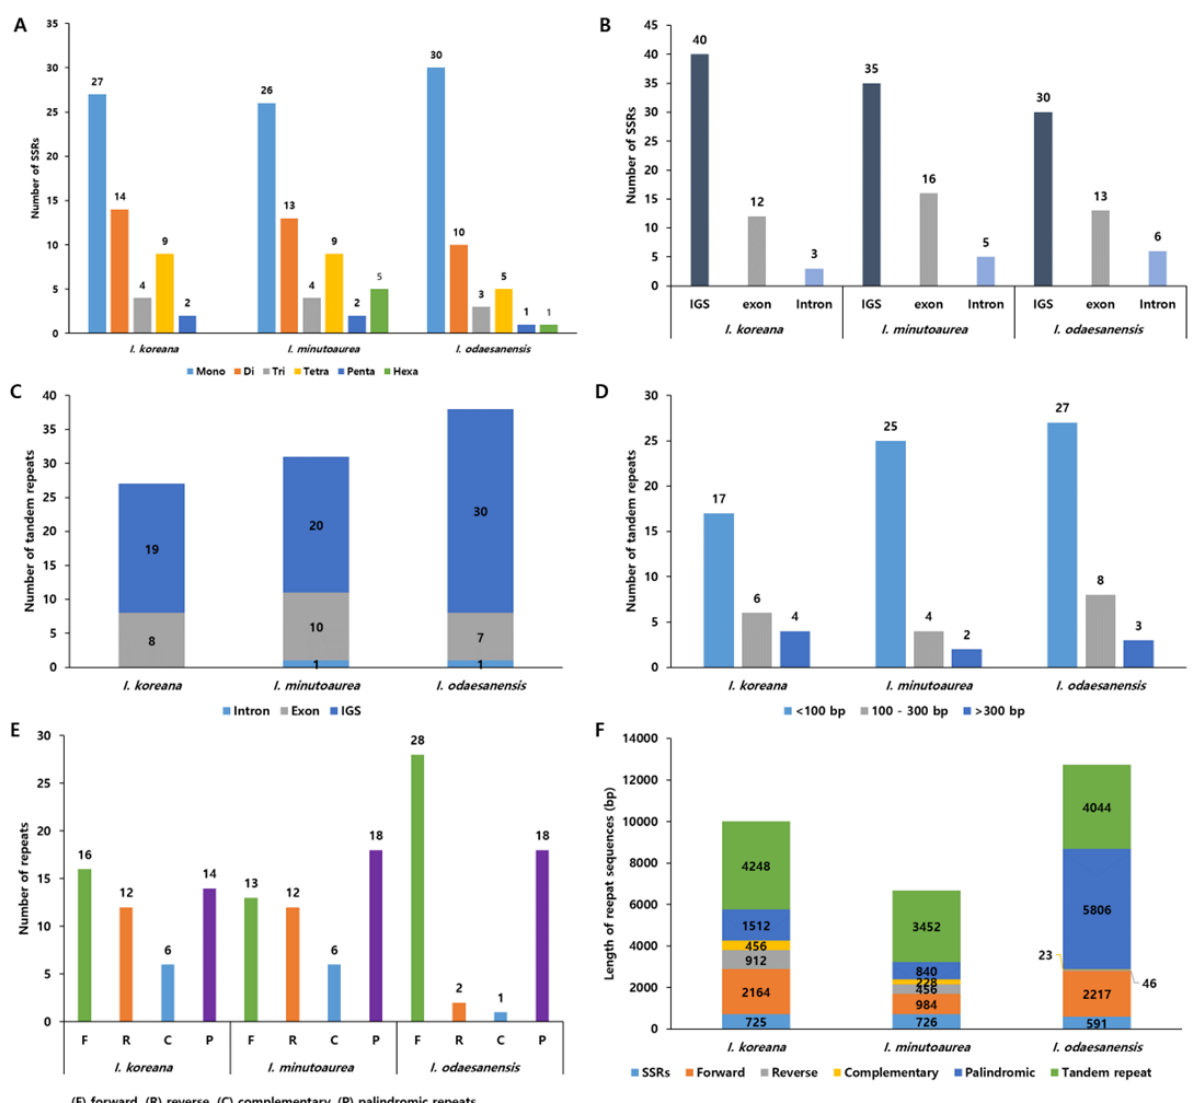
Figure 4. Distribution of the repeat sequences in Iris cp genomes. ( A ) Distribution of SSR motif types (mono-, di-, tri-, tetra-, penta-, and hexanucleotides). ( B ) Distribution of simple sequence repeats (SSRs) in intergenic spacers (IGS), exons, and introns. ( C ) Number and distribution of tandem repeats. ( D ) Abundance of tandem repeats sorted by length. ( E ) Abundance of forward ( F ), reverse (R), complementary ( C ), and palindromic (P) repeats. ( F ) Profiles of the repeat length distribution in cp genomes and total length of repeats (in